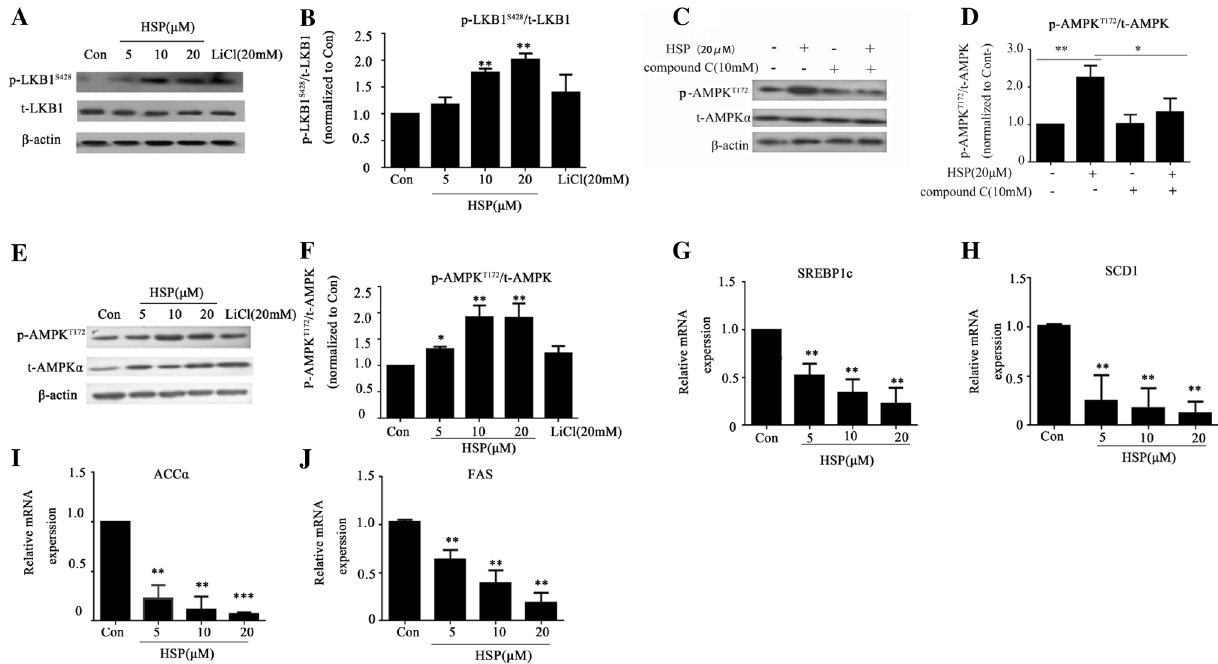
Fig. 5 Hypersampsone P regulated LKB1-AMPK signaling. a , b The expression of AMPK regulator protein, t-LKB1 and p-LKB1 Western blotting and quantitatively analyzed. c, d Protein lev- els of p-AMPK T172 treated by hypersampsone P and with/without an AMPK inhibitor, compound C and quantitatively analyzed. e , f Protein expression of t-AMPK, p-AMPK of the cells treated by